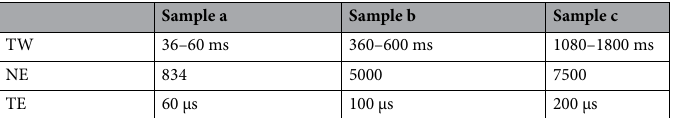
Table 1. Comparison of pulse sequence parameters used for continuous measurement of three different